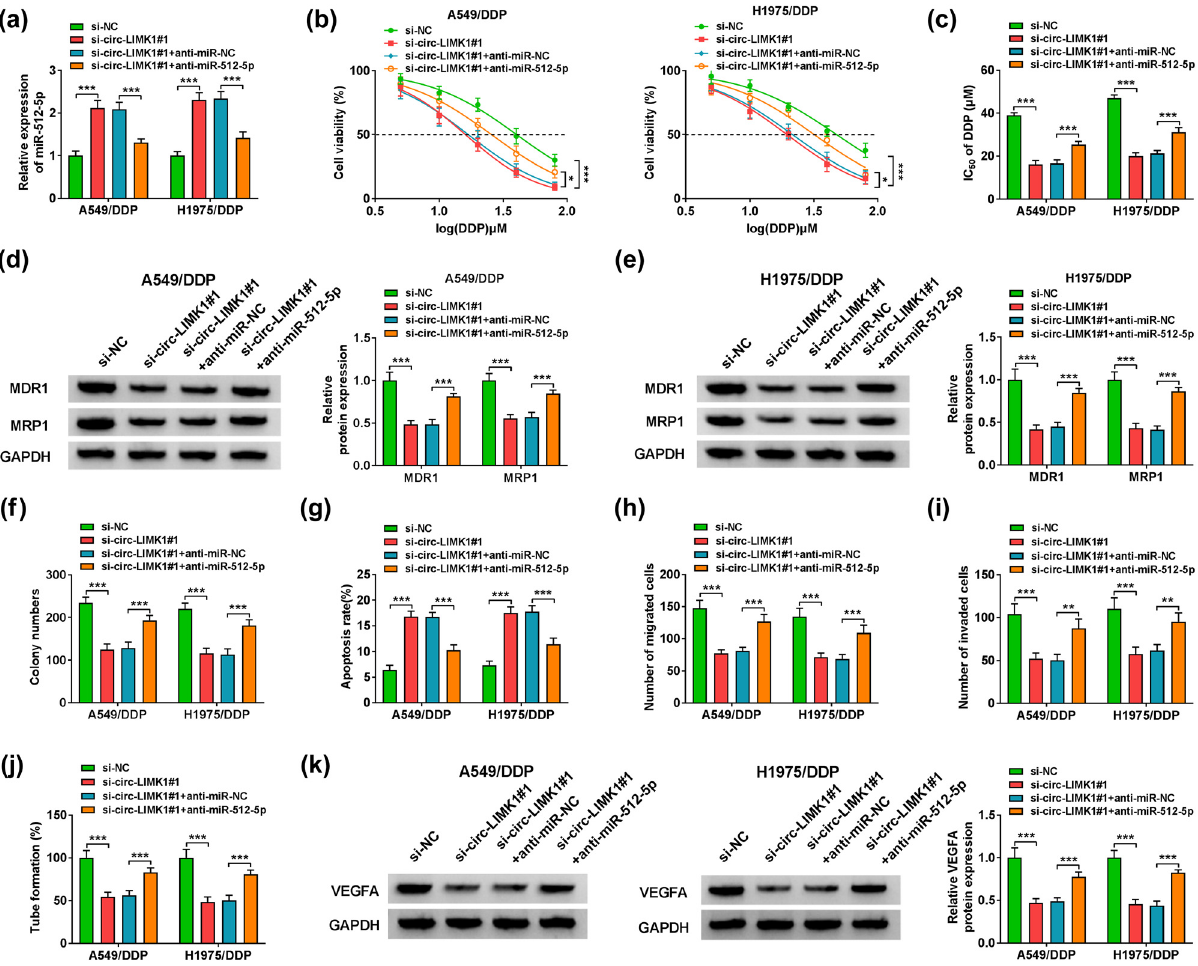
Figure 4: MiR - 512 - 5p could overturn the e ff ect of si - circ - LIMK1 in the progress of lung adenocarcinoma DDP - resistant cells. A549/DDP and H1975/DDP cells were transfected with si - NC, si - circ - LIMK1#1, si - circ - LIMK1#1 + anti - miR - NC, or si - circ - LIMK1#1 + anti - miR - 512 - 5p. ( a ) The expression of miR - 512 - 5p by RT - qPCR. ( b ) MTT assay was used to measure cell viability. ( c ) The IC 50 value of A549/DDP and H1975/DDP cells was measured by using MTT assay. ( d and e ) Western blot was used to measure the expression of MDR1 and MRP1. ( f ) The number of colonies was measured by colony formation assay. ( g ) Cell apoptosis was detected by fl ow cytometry. ( h and i ) Cell migration and invasion was tested by transwell assay. ( j ) Tube formation assay was employed to analyze tube formation. ( k ) Western blot was adopted to detect the expression of VEGFA. * P < 0.05, ** P < 0.01, *** P <